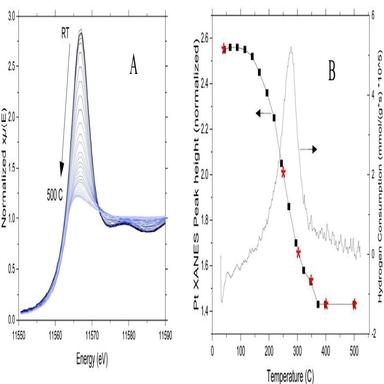
Pt L3-edge XANES during TPR from RT to 500 °C (A). Pt white line height as a function of temperature during TPR overlaid with H2 consumption (B).